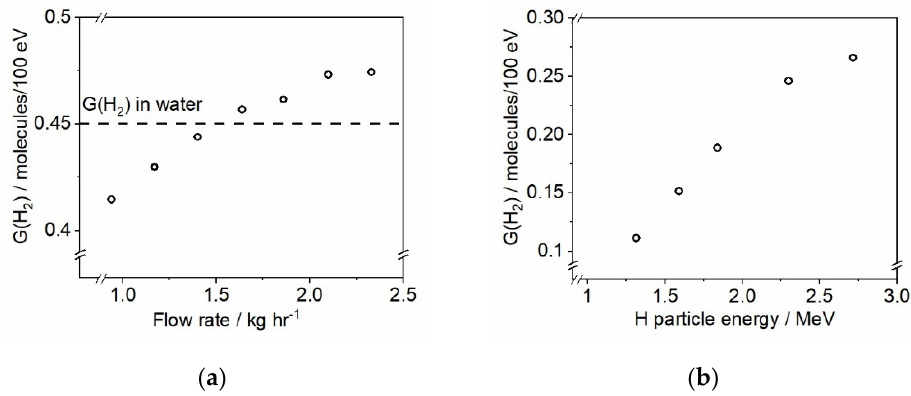
Figure 10. ( a ) Determined G-value of molecular hydrogen as a function of the fluid flow rate (kg/h) through the autoclave upon gamma irradiation of deaerated 1 mM KBr solution. ( b ) Radiation chemical yield of H 2 from a scavenger system containing 1 mM NO 3 − , 1 mM Br − , and 10 mM CHO 2 − under deaerated conditions and room temperature irradiated with a proton beam as a function of particle energy. All irradiations were performed using 10 nA current with exposures lasting for 15